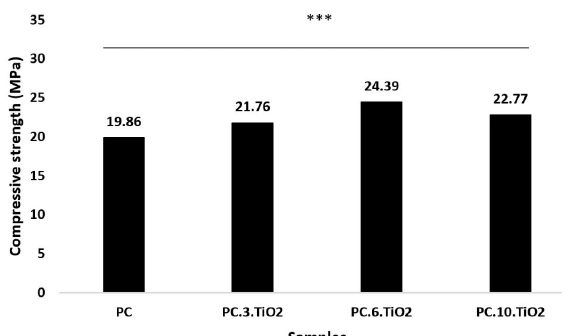
Figure 13 Average samples results of Compression Resistance tests. *** Statistically significant difference by the Tukey test p <0.001.